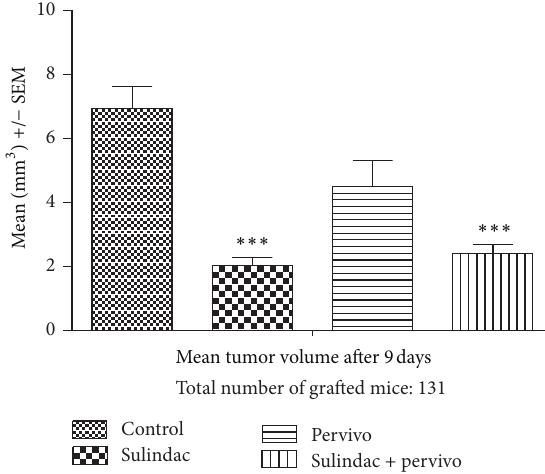
Figure 3: % of mice with measurable tumors in various days after L-1 sarcoma cells grafting. Table 3: Statistical analysis of the results presented in Figure 3. Chi-square Chi-square, df. 23.55, 9 𝑃 value 0.0051